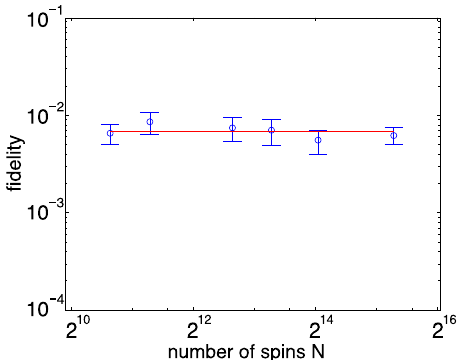
Fig. 4 The computing fi delities for number sets with different spin sizes. The fi delity is computed for the spin sizes N = 1600, 2500, 6400, 10,000, 16,900, 40,000. The error bars indicate the standard error of the mean for the samples. The red line corresponds to the averaged computing fi delity for all the